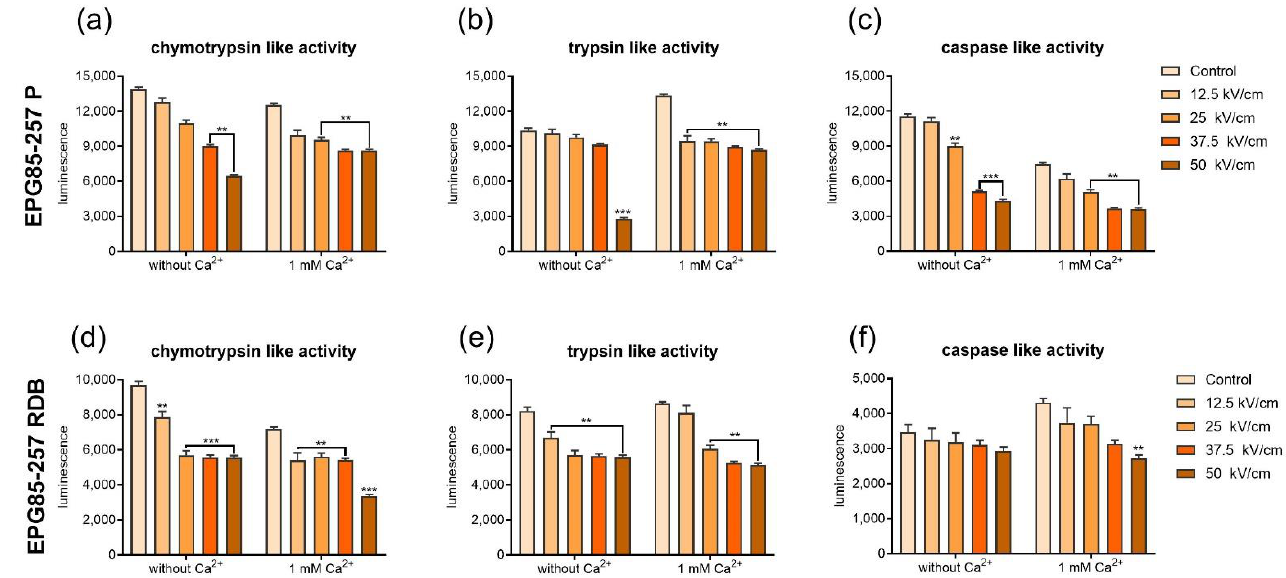
Figure 7. The evaluation of proteasomal activity after the exposure to nsPEFs alone or with calcium ions for EPG85-257 P cells: ( a ) chymotrypsin-like activity, ( b ) trypsin-like activity, ( c ) caspase-like activity, and EPG85-257 RDB cells: ( d ) chymotrypsin-like activity, ( e ) trypsin-like activity, ( f ) caspase-like activity. Data are mean ± SD (n = 3 independent experiments), ** p < 0.05.